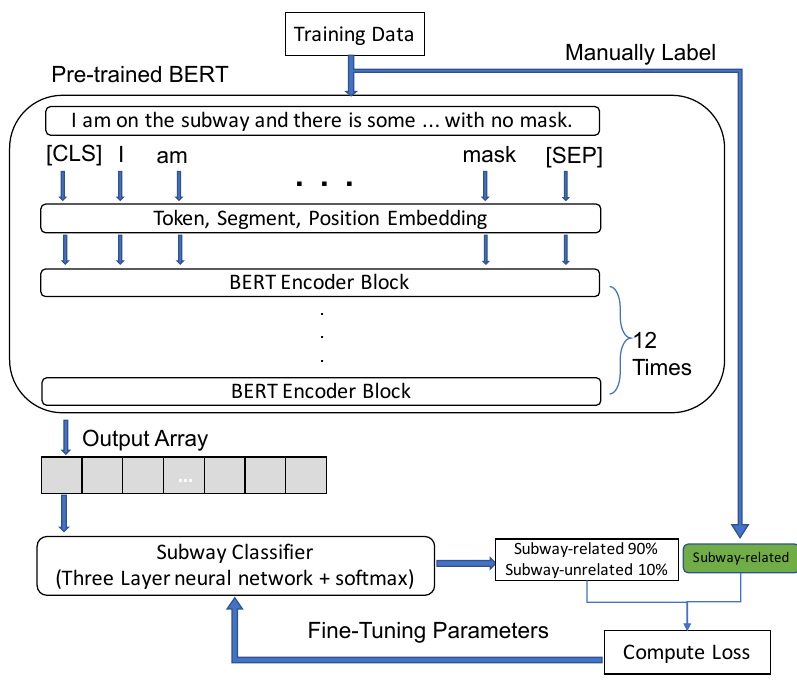
Figure 2. Subway